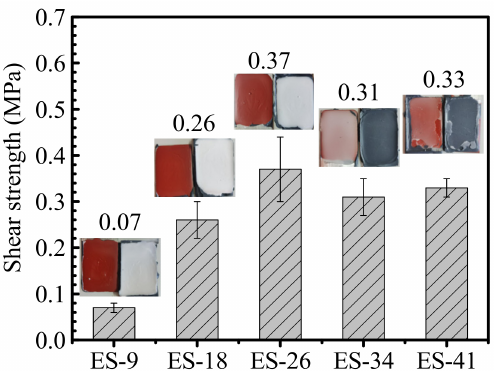
Figure 8. Shear strength of epoxy-modified silicone tie-coating and the matching coating system. It can be found that with the increase of E51 content in the tie-coating from 9% to 26%, the shear strength of the matching coating system increases from 0.07 Mpa to 0.37 Mpa. The latter is the greatest value of shear strength at breaking. Increasing the E51 content to